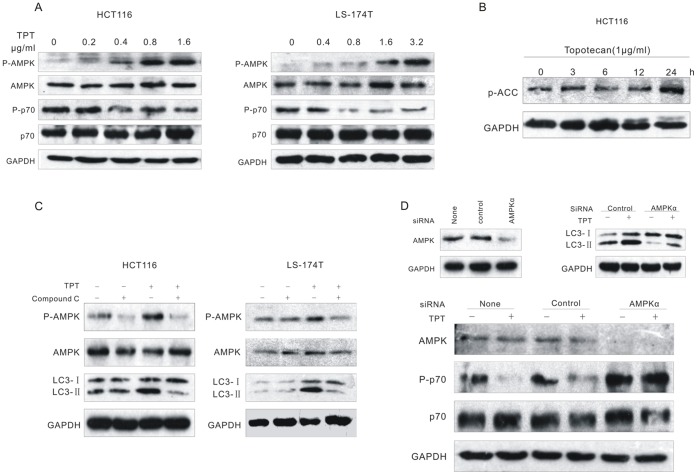
Topotecan treatment induced autophagy through the AMPK-mediated inhibition of mTORC1 in p53 wild-type colon cancer cells. A.HCT116 and LS-174T cells were treated with TPT for 24 h. The expression levels of the indicated proteins were analysed by immunoblotting. B. HCT116 cells were treated with 1 µg/mL TPT for the indicated times. The cell lysates were analysed by immunoblotting with phospho-ACC antibodies. C. The cells were treated with 1 µg/mL TPT and/or 20 µM compound C for 24 h, and the expression levels of the indicated proteins were analysed by immunoblotting. D. HCT116 cells were transfected with control or AMPKα siRNAs for 48 h, treated with or without 1 µg/mL TPT, and the level of the indicated proteins were subsequently analysed by immunoblotting.